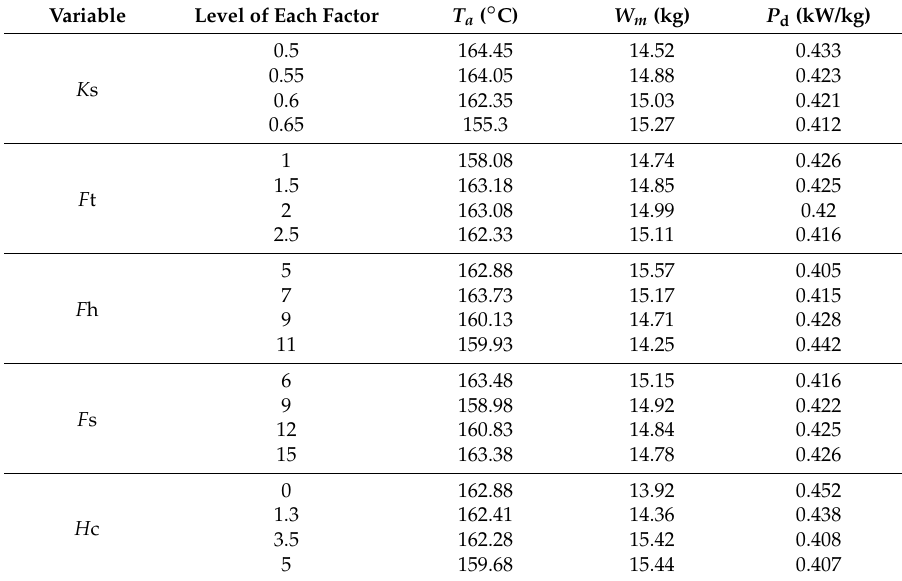
Table 10. Average values of performance under each level of factor variable